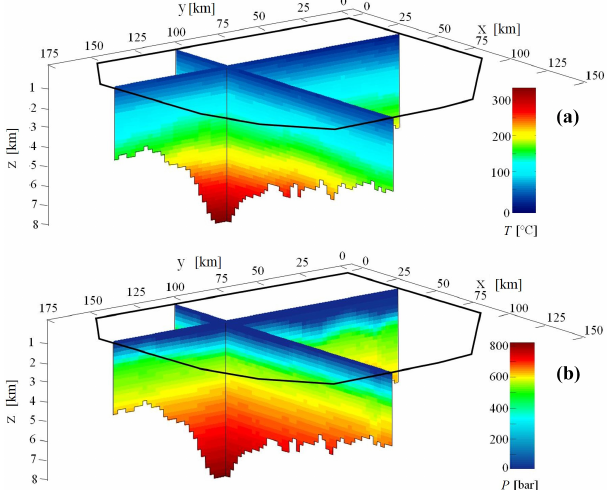
Figure 3. Evolution of temperature ( T , ◦ C, panel a ) and pressure ( P , bar, panel b ) simulated at the present time, i.e., t = 0Ma, along two perpendicular planar sections at x = 32km and y =